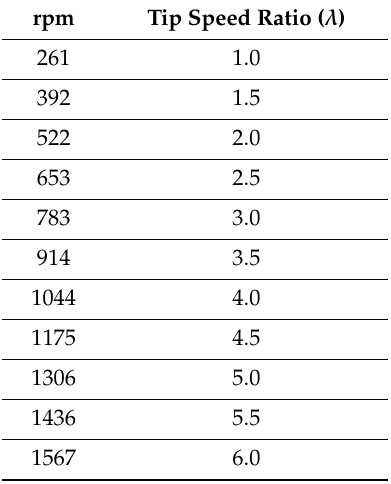
Table 3. Wind turbine rotor